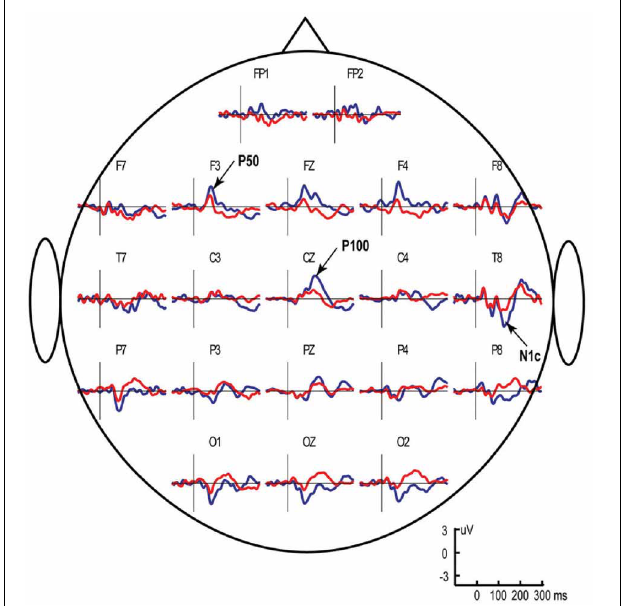
FIGURE 1 | Grand average ERP responses to left monaural “S1” (blue line) and “S2” (red line) clicks in typically developing children aged 3–8 years. The S1–S2 interval was fixed at 1s, while the S2–S1 interval varied between 7 and 9s. Vertical lines mark stimulus onset. Note presence of two anteriorly positive components that comprise the “P1-complex”—P50 at approximately 70ms after stimulus onset (maximal at frontal areas) and P100 at approximately 130ms (maximal at Cz). The figure is adapted from Stroganova et al.